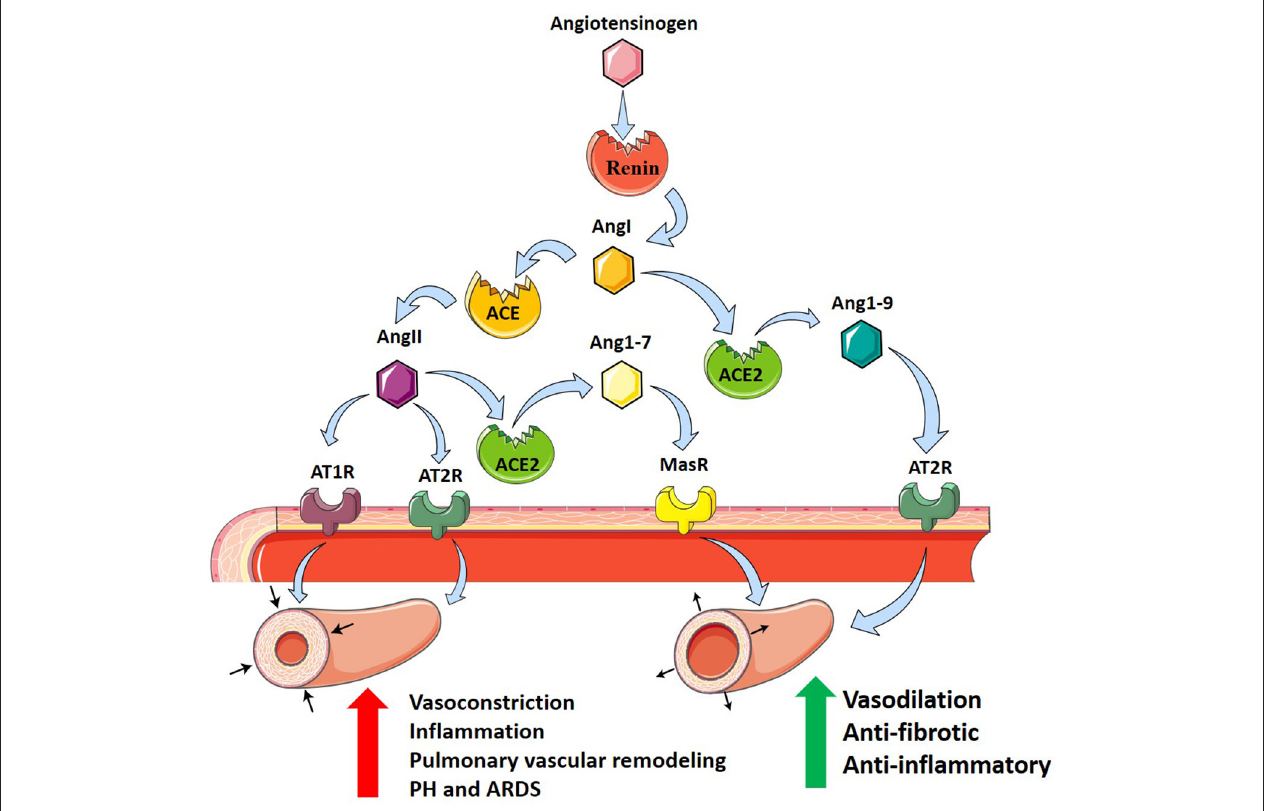
FIGURE 1 | The renin–angiotensin system and its contribution to PH in ARDS. Angiotensinogen (pink hexagon) is cleaved by renin (red circle) into angiotensin I (AngI, orange hexagon). Angiotensin-converting enzyme (ACE, orange circle) cleaves AngI producing angiotensin II (AngII, purple hexagon) which binds to angiotensin II receptor type 1 (AT1R, purple receptor) and angiotensin II receptor type 2 (AT2R, teal receptor), resulting in vasoconstriction, inflammation, and pulmonary vascular remodeling promoting PH in ARDS. Alternatively, angiotensin-converting enzyme 2 (ACE2, green circle) cleaves AngI producing angiotensin1–9 (Ang1–9, blue hexagon) which binds to AT2R, or AngII to produce angiotensin1–7 (Ang1–7, yellow hexagon) which binds to Mas receptor (MasR, yellow receptor). ACE2 counterbalances ACE, protecting against PH in ARDS through anti-fibrotic and anti-inflammatory actions and